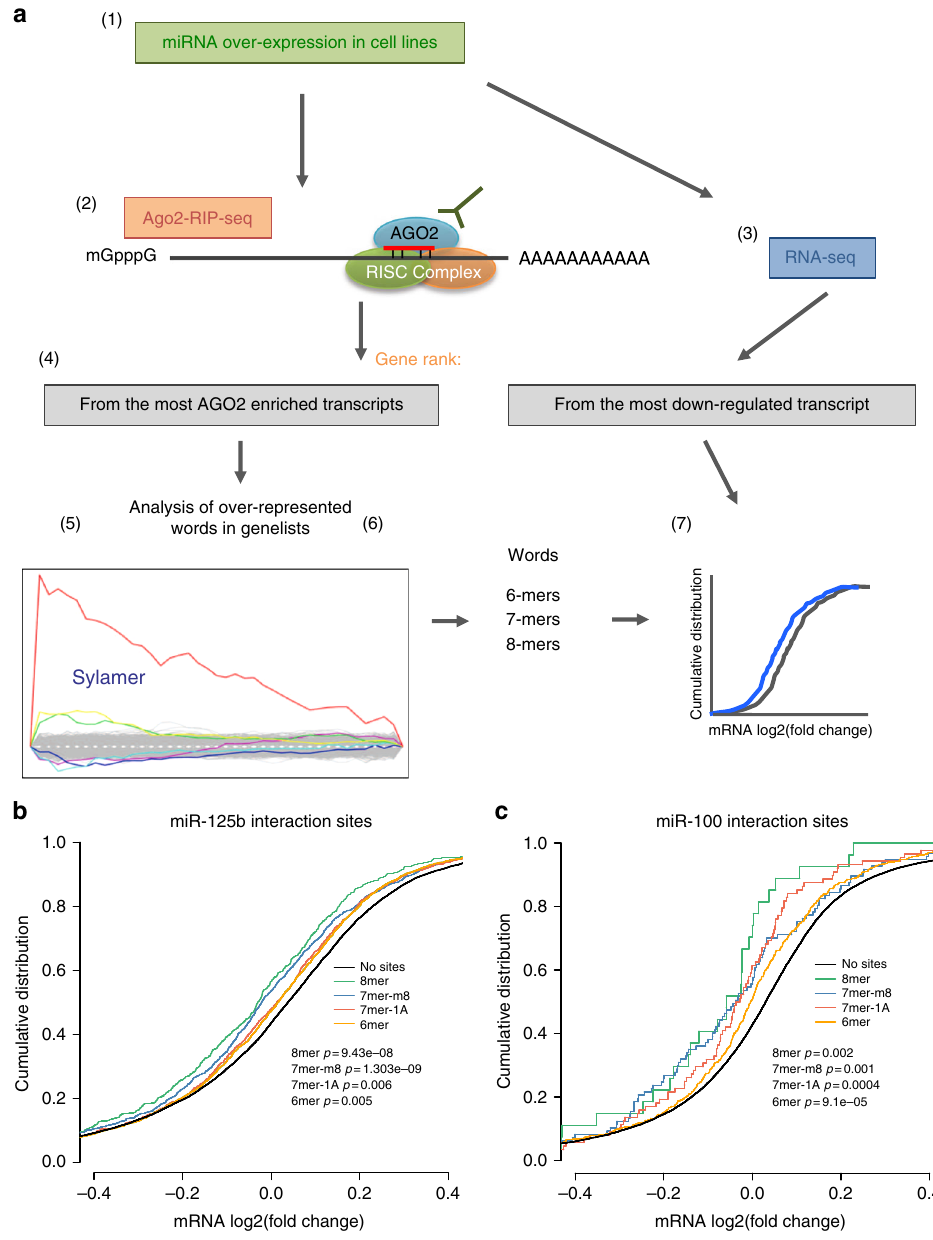
Fig. 6 RIP-USE identi fi es miR-125b and miR-100 targets in PDAC. a Schematic overview of the steps of the experimental and computational analysis pipeline of RIP-USE for the identi fi cation of miRNA targets. b The fold change of transcript levels mediated by the overexpression of miR-125b is analyzed comparing transcripts containing 6 – 8mers with transcripts lacking these motifs in 3 ′ UTRs. c The fold change of transcript levels mediated by the overexpression of miR-100 is analyzed comparing transcripts containing 6 – 8mers with transcripts lacking these motifs in 3 ′ UTRs. P -values were calculated by two-sided Kolmogorov – Smirnov